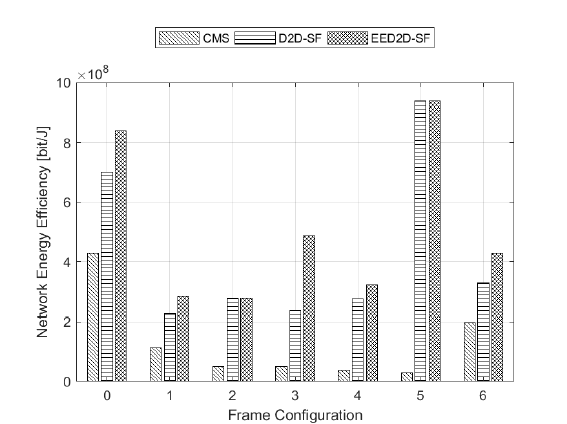
Figure 3. Network Energy Efficiency for all frame configurations.